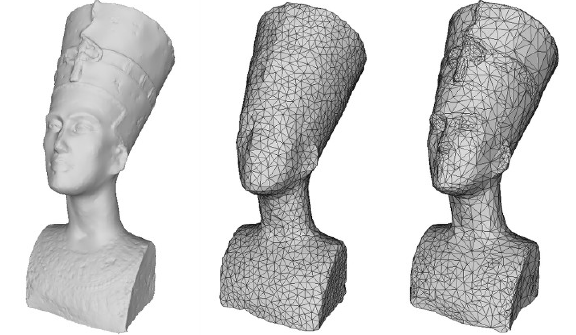
Figure 8: An exemple of a mesh decimating process applied to a 3Dmodel of a statue. Decimation of an input mesh to 1% of its original vertices, using different